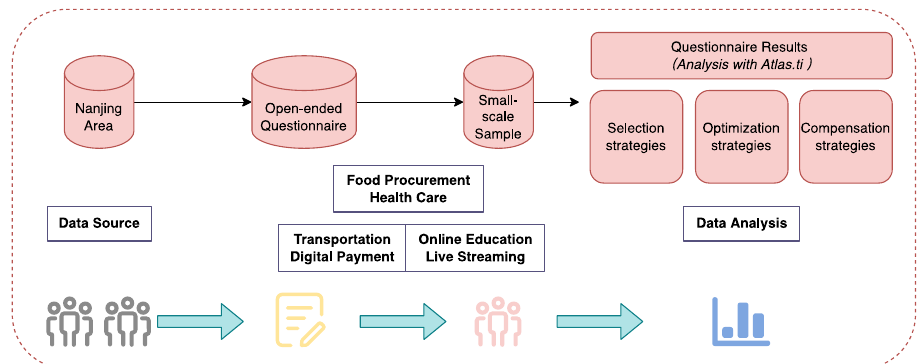
Figure 5. Qualitative study design.